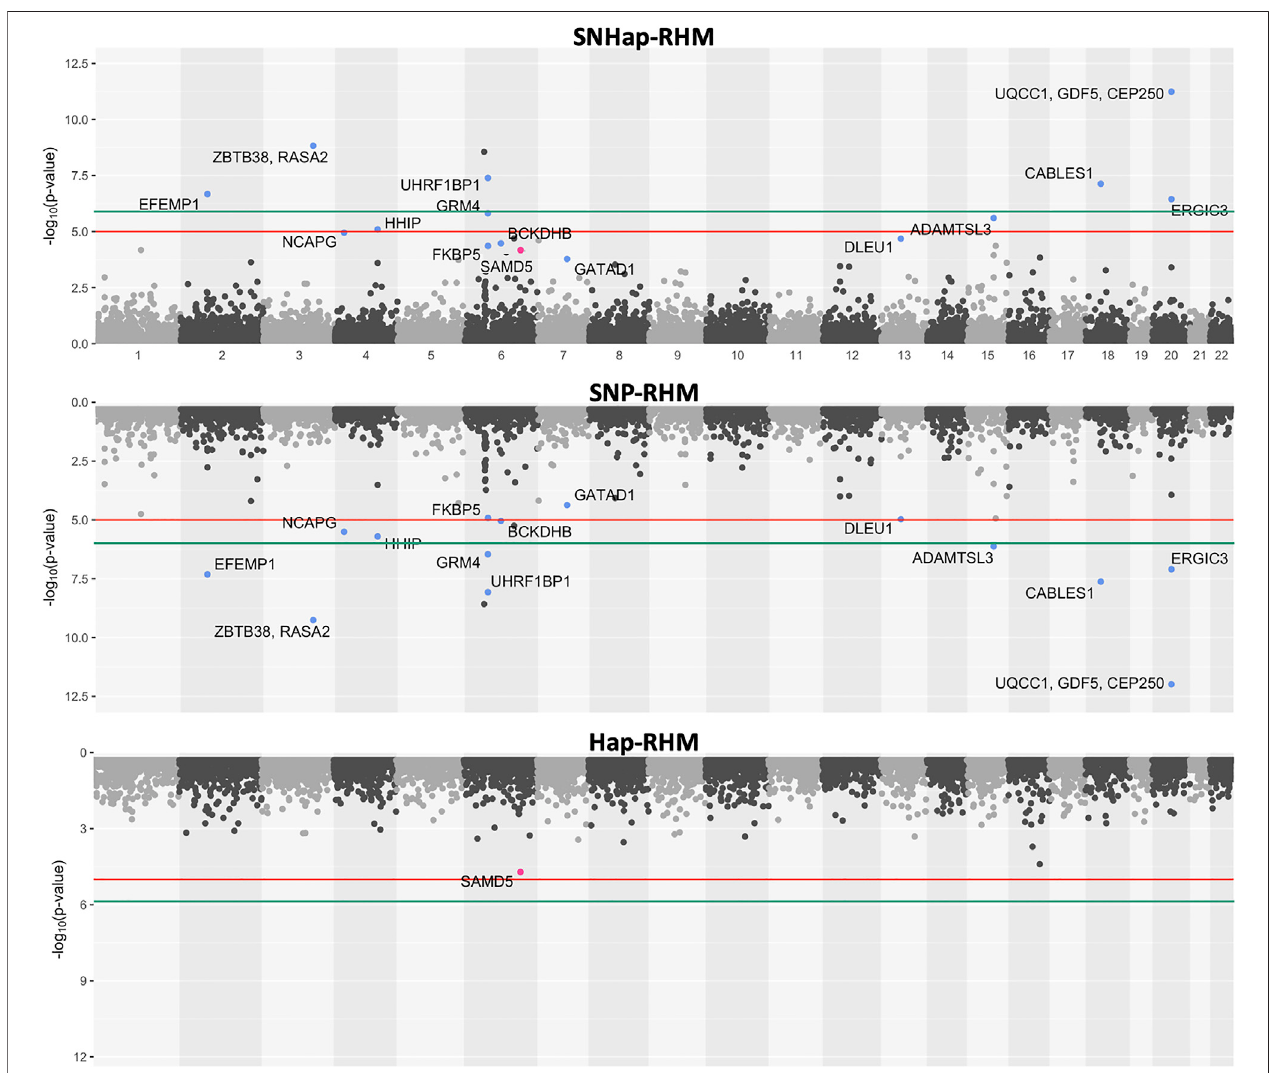
FIGURE5| Thegenome-wideevidenceofhaplotypeblockassociationforheight.AnalysisdonewithSNHap-RHM,SNP-RHMandHap-RHM.Thepointsareplots of − log10 of the p -values of regions tested with the LRT for the regional GREML analyses. The green lines are the Bonferroni-corrected genome-wide signi fi cance thresholdandtheredlinesarethesuggestivesigni fi cancethresholdcalculatedtobe p -value < 1 × 10 − 5 .Thetopassociationhitsat p -value < 5 × 10 − 5 withgeneslocated within the region are highlighted in blue for SNP-RHM and red for the Hap-RHM.